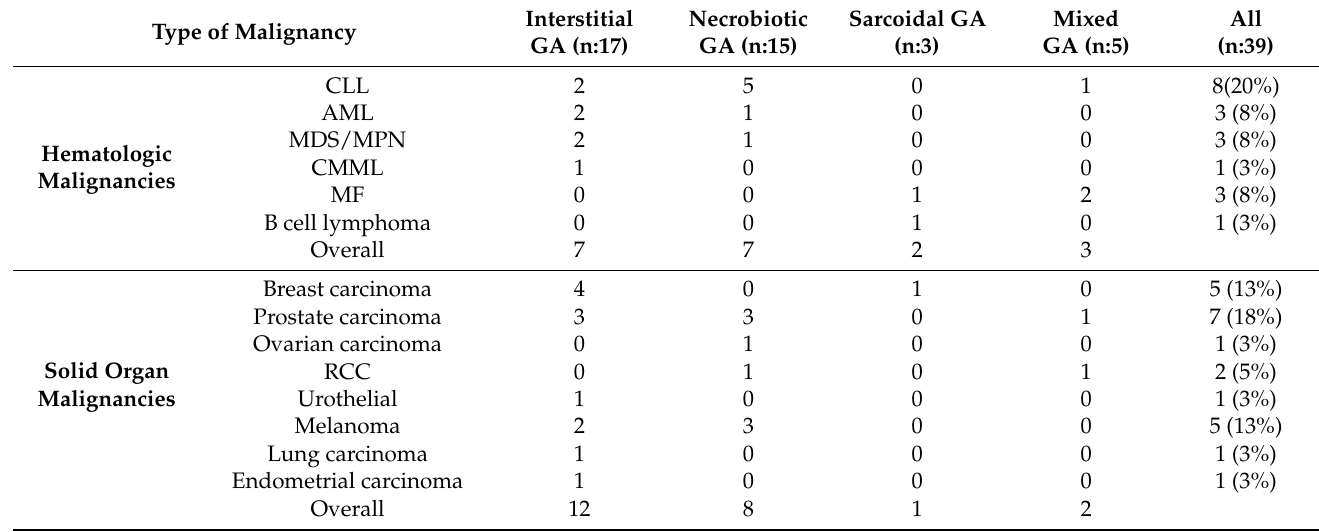
Table 2. Histopathologic patterns of the MGA cases and associated malignancy types.